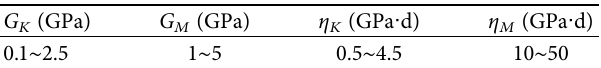
Figure 9: (a) Tunnel numerical model. (b) Layout of monitoring section. Table 2: Range of parameters to be back